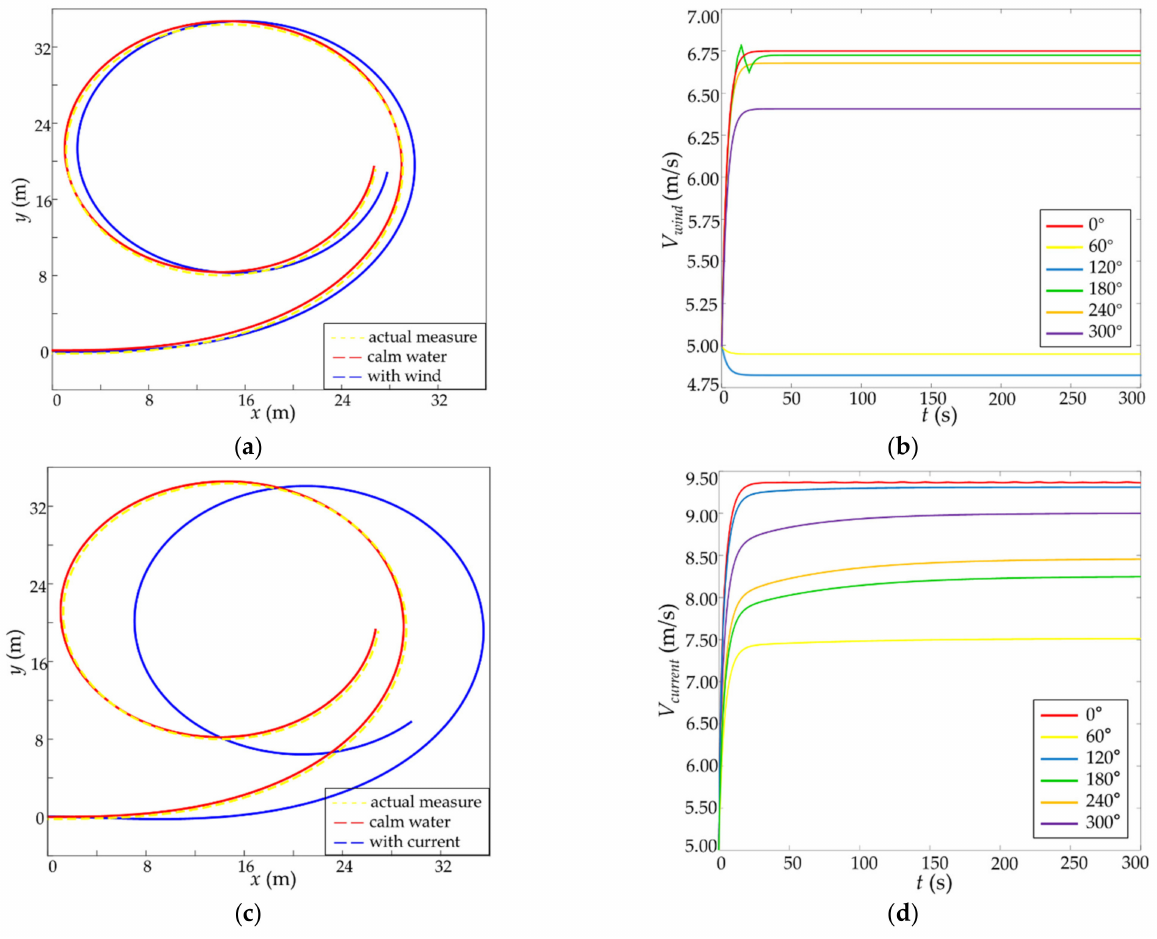
Figure 7. Motion simulation experiment of Dolphin-I USV under environmental interference. ( a ) The gyroscopic trajectory with or without wind; ( b ) The change of direct sailing speed in different wind directions; ( c ) The gyroscopic trajectory with or without current; ( d ) The change of direct navigation speed under different current